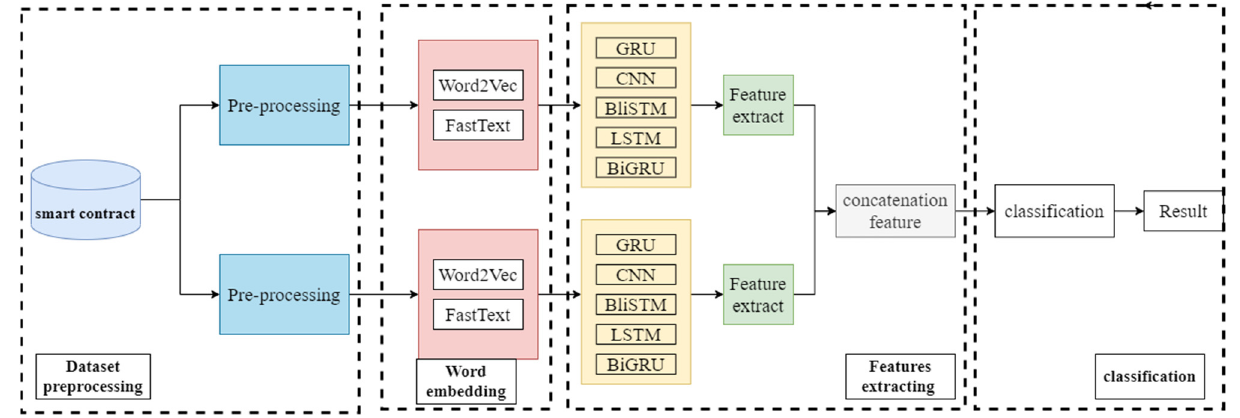
Figure 4. Hybrid network overall framework in this paper.